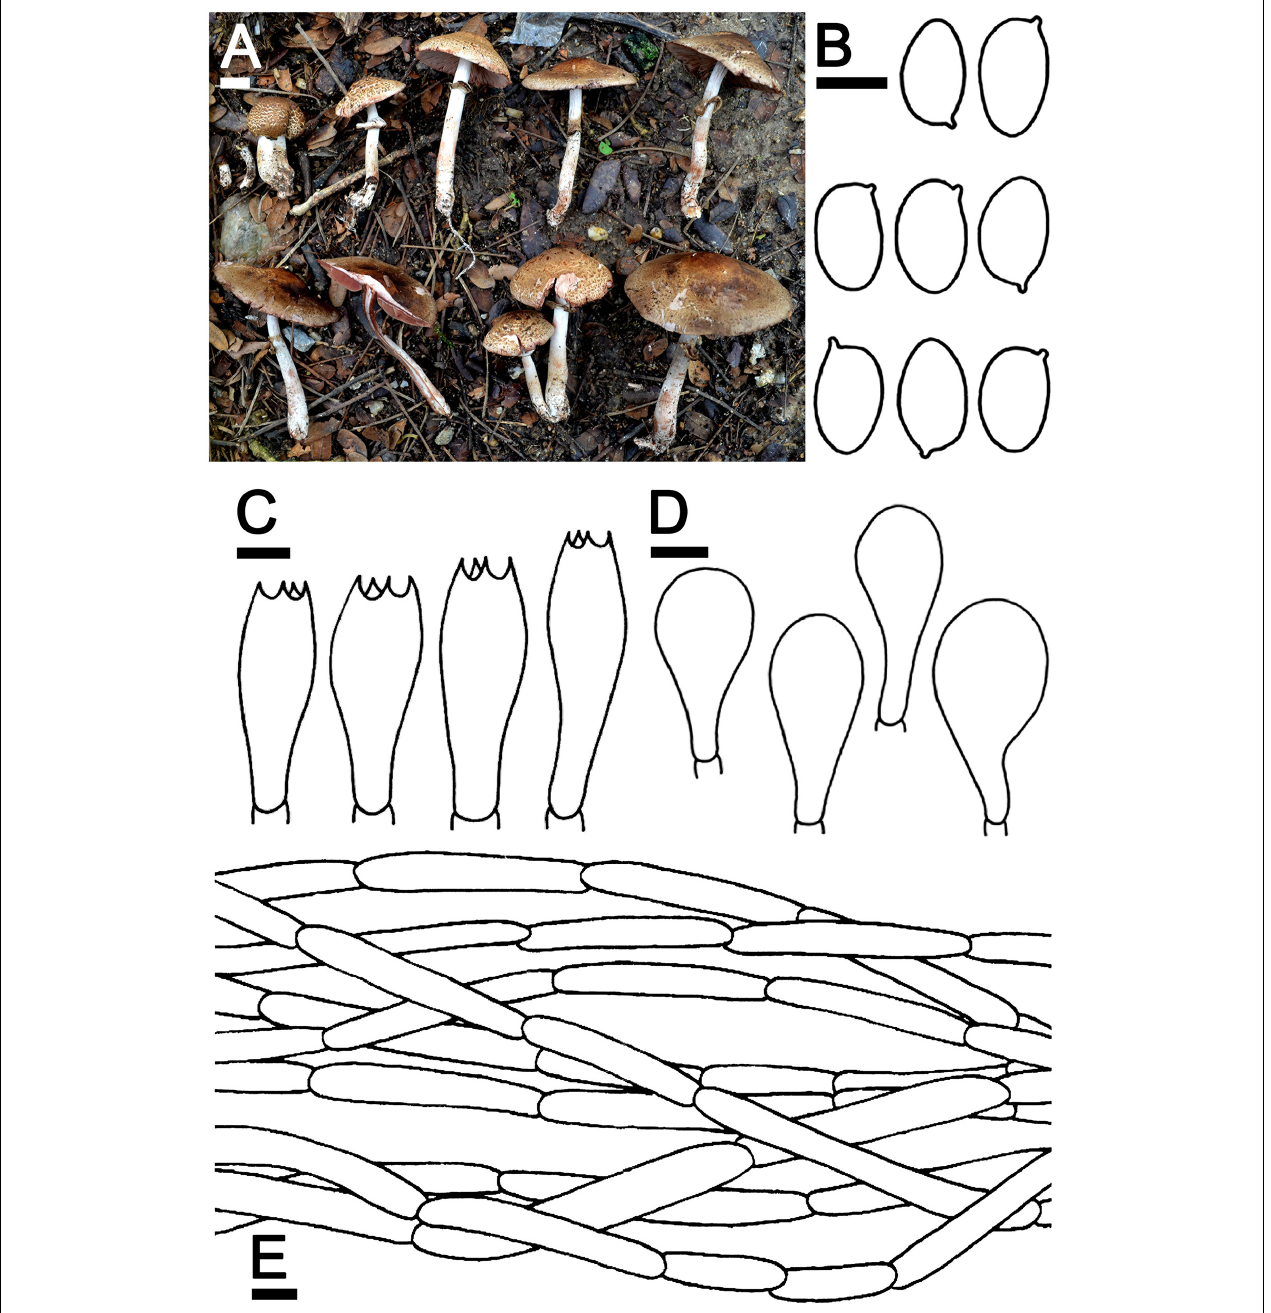
FIGURE 3 | Agaricus lannaensis SDBR-NK0564 (holotype). (A) Basidiomata on the field, (B) Basidospores, (C) Basidia, (D) Cheilocystidia, (E) Pileipellis. Scale bars (A) = 1 cm and (B–E) = 5 µ m.